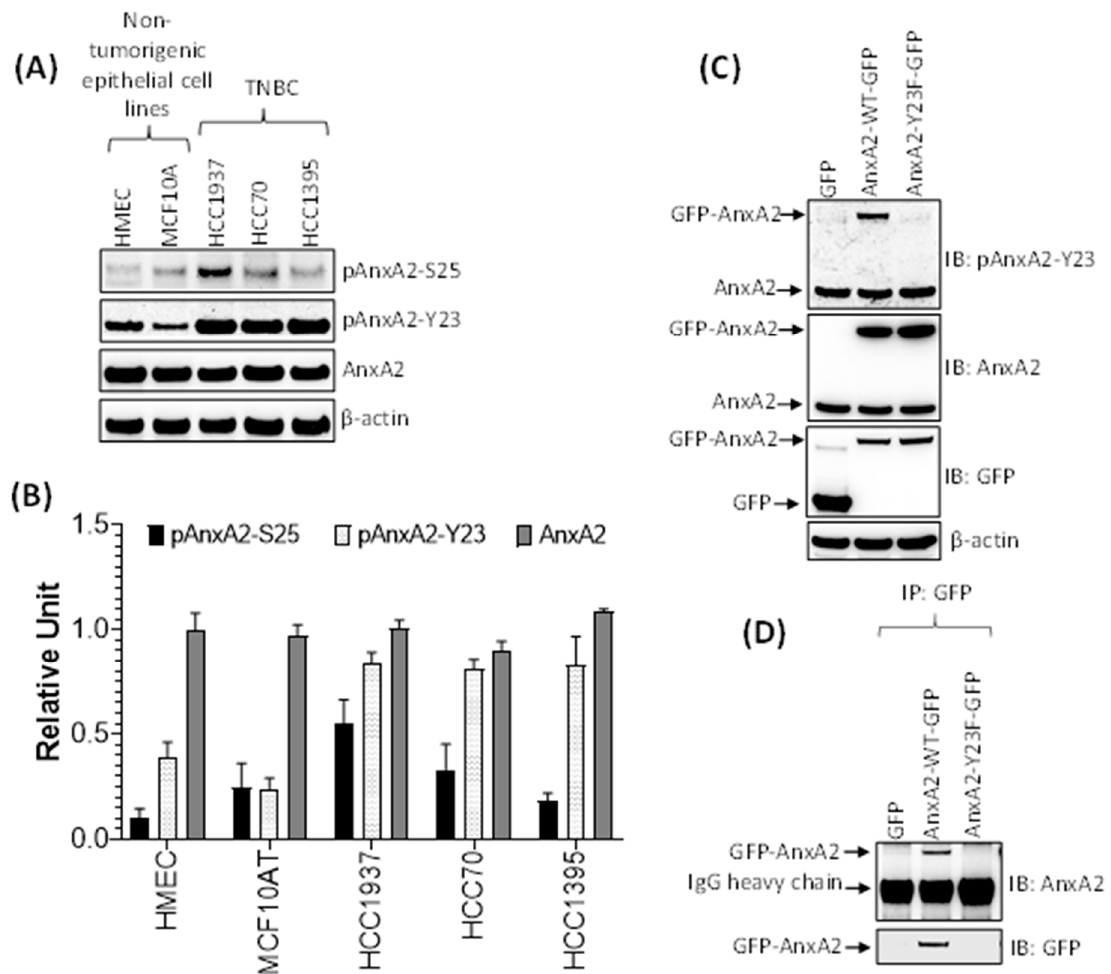
Figure 5. Phosphorylation of AnxA2 in breast cancer cells. ( A ) The expression of pAnxA2-S25, pAnxA2-Y23, and AnxA2 were analyzed in non-tumorigenic mammary epithelial cells and TNBC cells by immunoblot analysis. The membrane was stripped and reprobed with anti- β -actin antibody for loading control. ( B ) Bar chart showing the densitometric analysis of pAnxA2-S25, pAnxA2-Y23 and AnxA2 bands of the immunoblot of panel A. Intensity of each bands were normalized by loading control. Each bar represents the mean ± SE of three independent experiments. ( C ) The HCC1395 cells were transfected with a plasmid vector expressing GFP alone, AnxA2-WT-GFP, and AnxA2-Y23F-GFP. The expression of pAnxA2- Y23, AnxA2 and GFP were analyzed by immunoblot analysis. The membrane was stripped and reprobed with anti- β -actin antibody for loading control. ( D ) The HCC1395 transfected cells (6 x 10 5 ) were plated in 100mm Petri dish for overnight and then switched to serum free medium. After 24 h, the AnxA2-GFP complex was immunoprecipitated from the medium using anti-GFP antibody (Catalog no. DSHB-GFP-12A6; DSHB) and expression of AnxA2 secretion was analyzed by anti-AnxA2 antibody using immunoblot analysis. Uncropped Western Blots of ( A ), ( C ) and ( D ) are available in Figure S3.